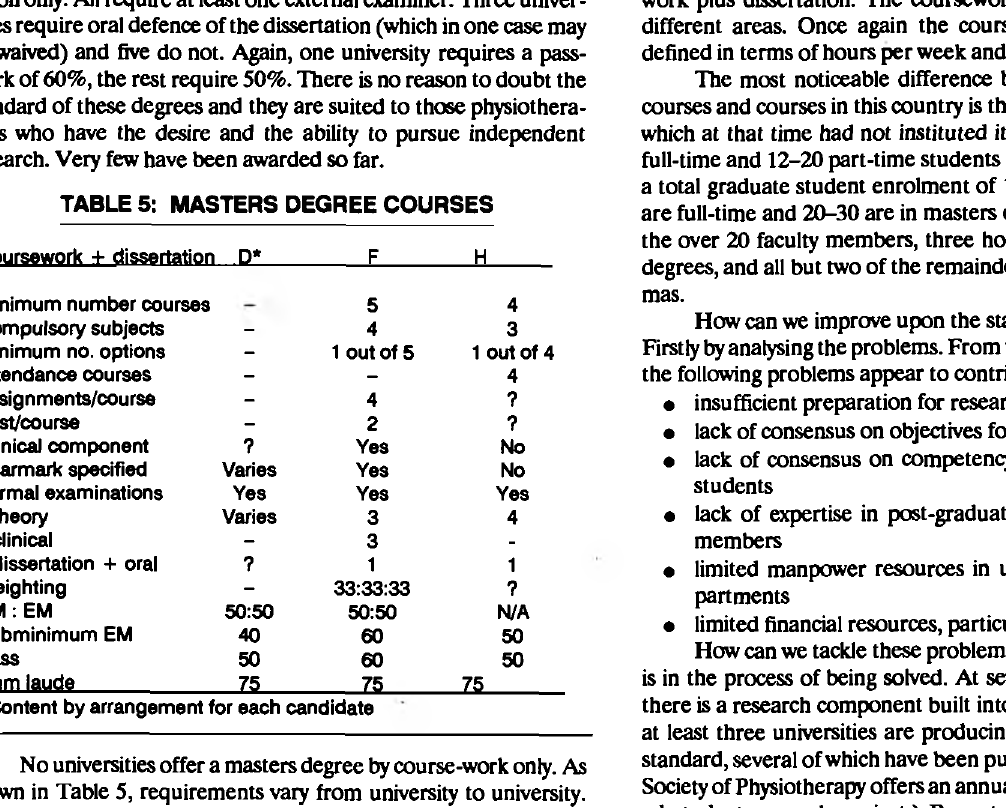
TABLE 5: MASTERS DEGREE COURSES Coursework + dissertation D* Minimum number